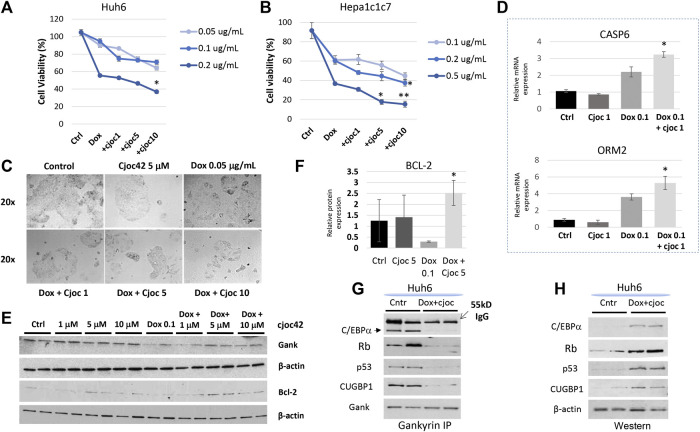
A combination therapy of doxorubicin and Cjoc42 enhances cytotoxicity. (A) Cytotoxicity Assay with doxorubicin (0.05, 0.1, and 0.2 µg/mL) and increasing concentrations of Cjoc42 (1, 5, and 10 µM) in Huh6 cells. (B) Cytotoxicity Assay with doxorubicin (0.1, 0.2, and 0.5 µg/mL) and increasing concentrations of Cjoc42 (1, 5, and 10 µM) in Hepa1c1c7 cells. (C) Microscope pictures at 20x showing reduction in size and number of clustered Huh6 cells when treated with doxorubicin 0.05 µg/mL and increasing concentrations of Cjoc42 compared to Cjoc42 or doxorubicin alone. (D) QRT-PCR data with Hepa1c1c7 cells treated with 1 µM Cjoc42 alone, Doxorubicin 0.1 µg/mL alone, or a combination of both. There was a statistically significant increase in expression of the apoptotic marker Casp6 with combination treatment (p < 0.05) and the mature hepatocyte marker ORM2 (p < 0.05). (E) Western blotting in Huh6 cells treated with Cjoc42 alone, doxorubicin 0.05 µg/mL, or a combination of doxorubicin and Cjoc42. (F) Bcl2 expression was calculated as a ratio to β-actin. Bcl2 is significantly higher in cells treated with doxorubicin 0.1 µg/mL and Cjoc42 5 µM compared to doxorubicin 0.05 µg/mL alone (p < 0.03). (G) Co-IP studies. Gank was immunoprecipitated from untreated Huh6 and from Huh6 cells treated with doxorubicin (0.05 µg/mL) and cjoc42 (5 µM). Tumor suppressor proteins were examined in these IPs. (H) Western blotting shows levels of tumor suppressor proteins in nuclear extracts of untreated and doxorubicin + cjoc42 treated Huh6 cells.